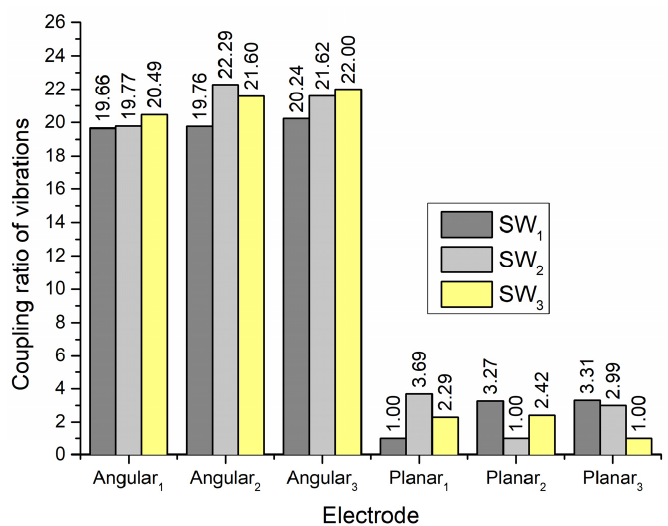
Figure 8. Vibration coupling ratios when electrodes Planar 1 –Planar 3 are excited. Figure 7. Comparison of displacement amplitudes while electrodes Planar 1 –Planar 3 are excited.